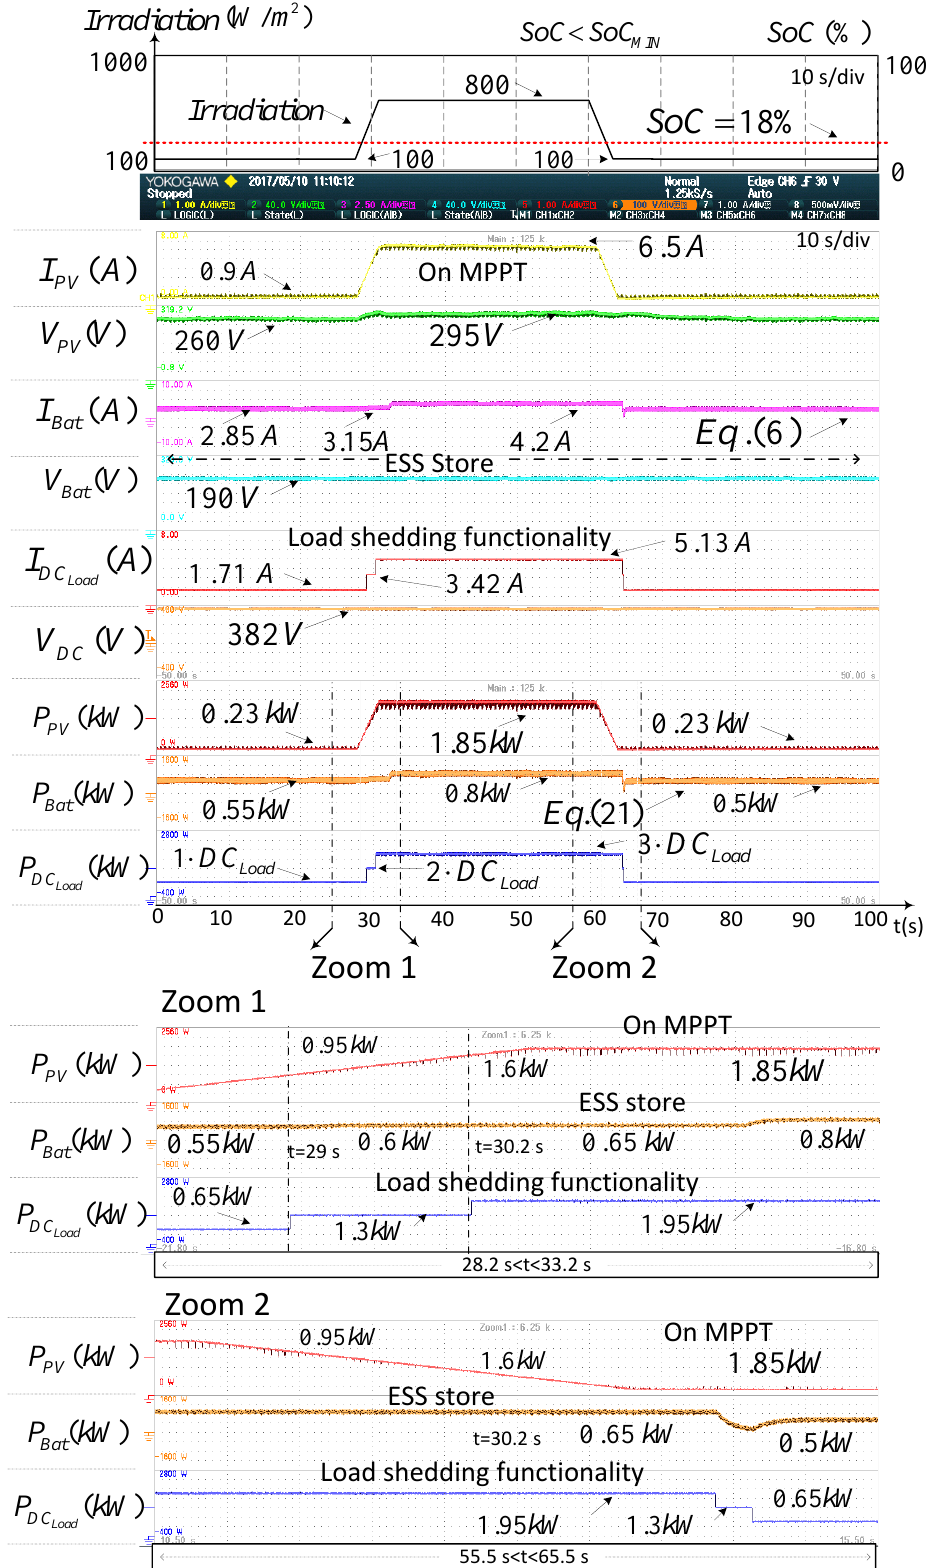
Figure 10. Experiment #2. Evolution of the currents, the power exchange and voltage in the DC microgrid for changes in the irradiation at a SoC < SoC MIN .